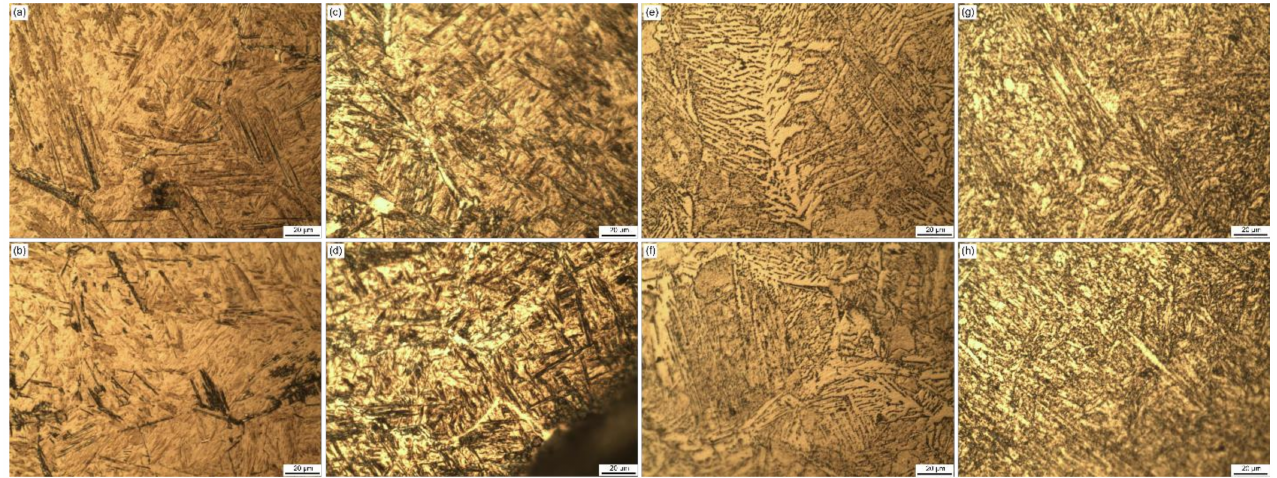
Figure 3. Micrography of rebars after thermomechanical treatments ( × 100): Water quenched (( a ) center, ( b ) edge), Oil quenched (( c ) center, ( d ) edge), subcritical annealing after water quenching (( e ) center, ( f ) edge), and subcritical annealing after oil quenching (( g ) center, ( h )